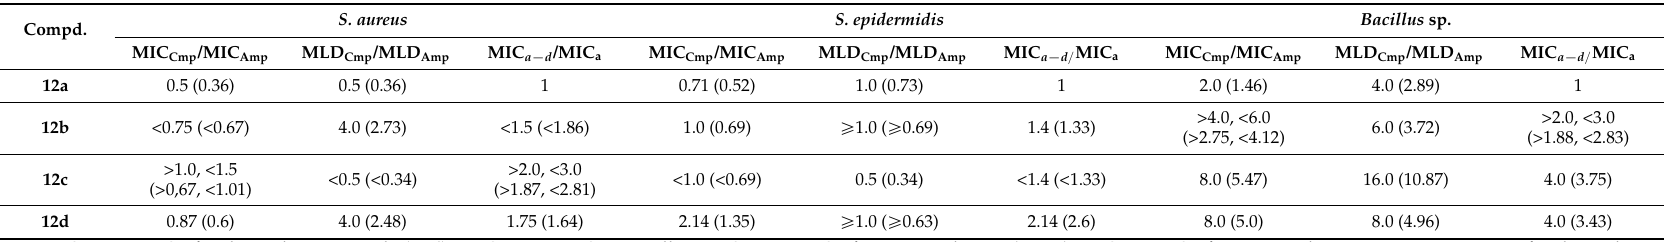
Table 2. Antimicrobial efficiency of compounds evaluated by MICs and MLDs ratios. In parentheses are indicate the ratios of the MIC expressed as molarity ( µ M). Each value was obtained from the ratio of MIC 100 indicated in Table 1.